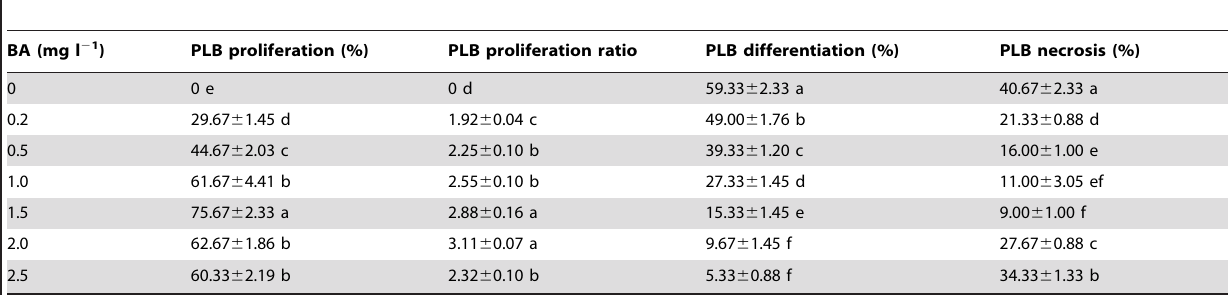
Means 6 SE of 300 replicates; different letters within each column are significantly different at P , 0.05 (DMRT). doi:10.1371/journal.pone.0110033.t004 PLOS ONE |